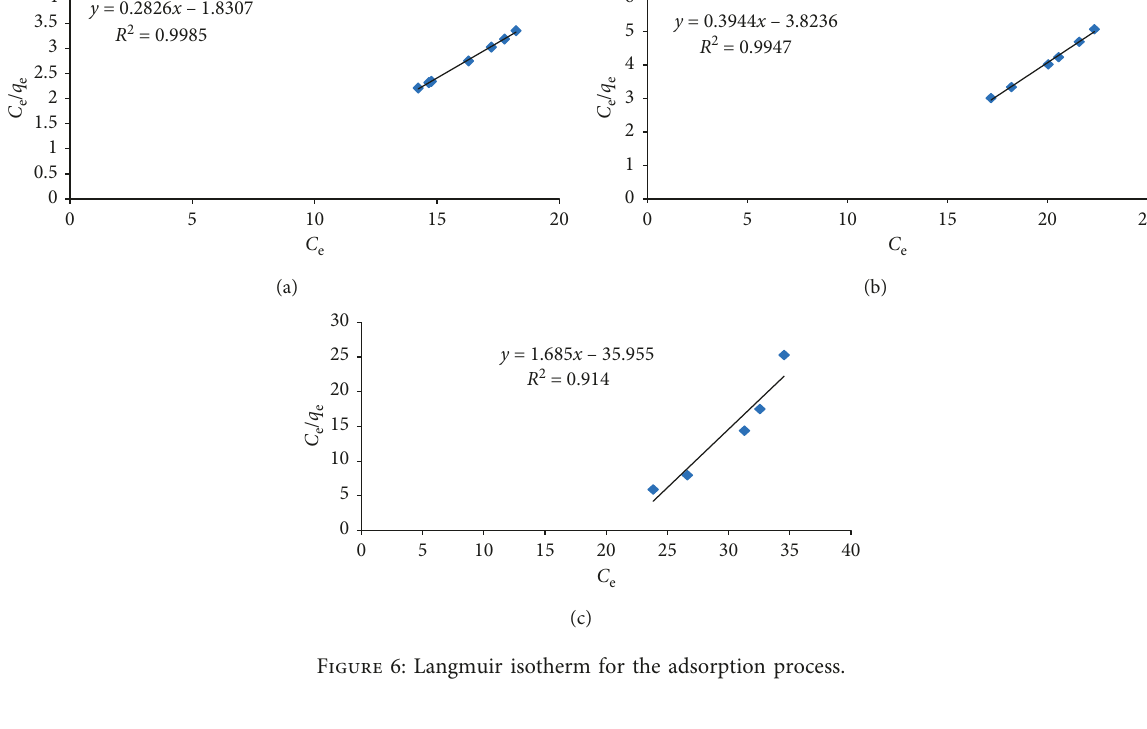
Figure 6: Langmuir isotherm for the adsorption process.